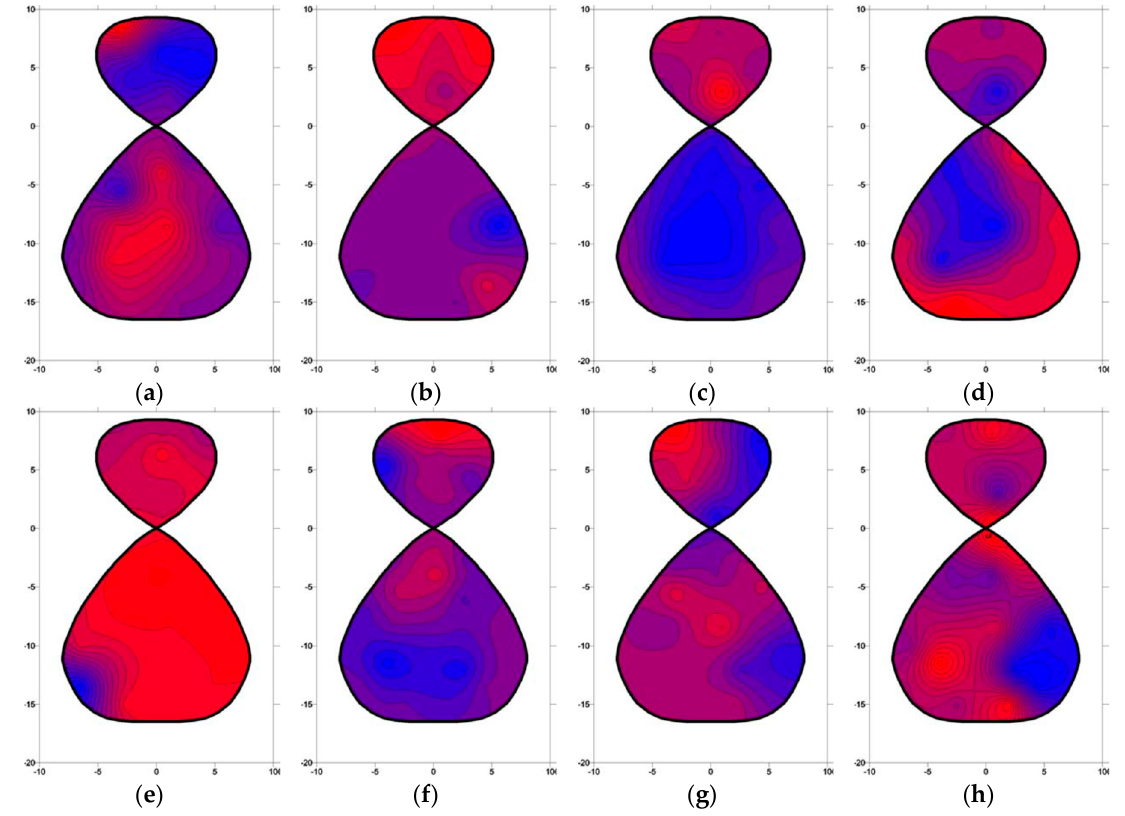
Figure 5. Results of modal analysis of the thar . Frequencies are ( a ) 32 Hz, ( b ) 269 Hz, ( c ) 322 Hz, ( d ) 462 Hz, ( e ) 592 Hz, ( f ) 689 Hz, ( g ) 882 Hz and ( h ) 1012 Hz.